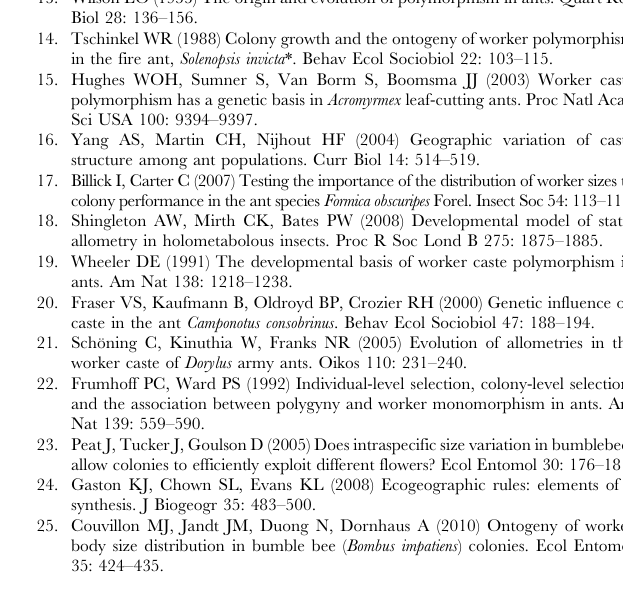
Table S1 Mean ( ± s.e.) mass (mg) for each sex, the chi- squared and p values from a generalized linear model (normal distribution, identity link function) investigat- ing sex-related size differences, and sample sizes (in parentheses) in each case. Where the sex was not determined the data are shown in the centre of the two columns.